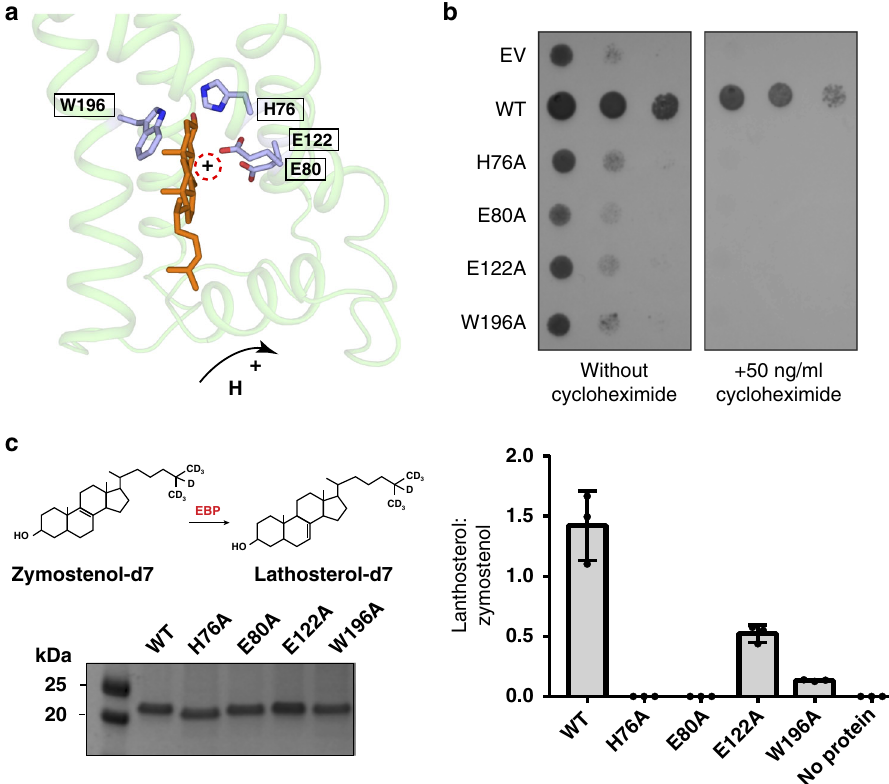
Fig. 4 The putative catalytic mechanism of EBP in the isomerization. a A top-scoring model of EBP and Δ 8 -sterol that was generated by Molecular Docking Simulations. The key resides of isomerization by EBP are shown as sticks. b Yeast complementation assay. EBP with the catalytic mutation cannot rescue the growth of Δ Erg2 Saccharomyces cerevisiae . Growth of yeast expressing EBP mutant in the presence of 50 ng/ml concentrations of cycloheximide for 24 to 48 h. c Enzymatic activity assay in vitro. EBP catalyzes the conversion of deuterium labeled zymostenol (zymostenol-d7) to lathosterol-d7. LC-MS/MS was used for isolation and analysis zymostenol-d7 and lathosterol-d7. The SDS-PAGE shows the puri fi ed recombinant proteins used in the assays. Data shown are the mean ± SD of triple times determinations. Source data are provided as a Source Data fi le